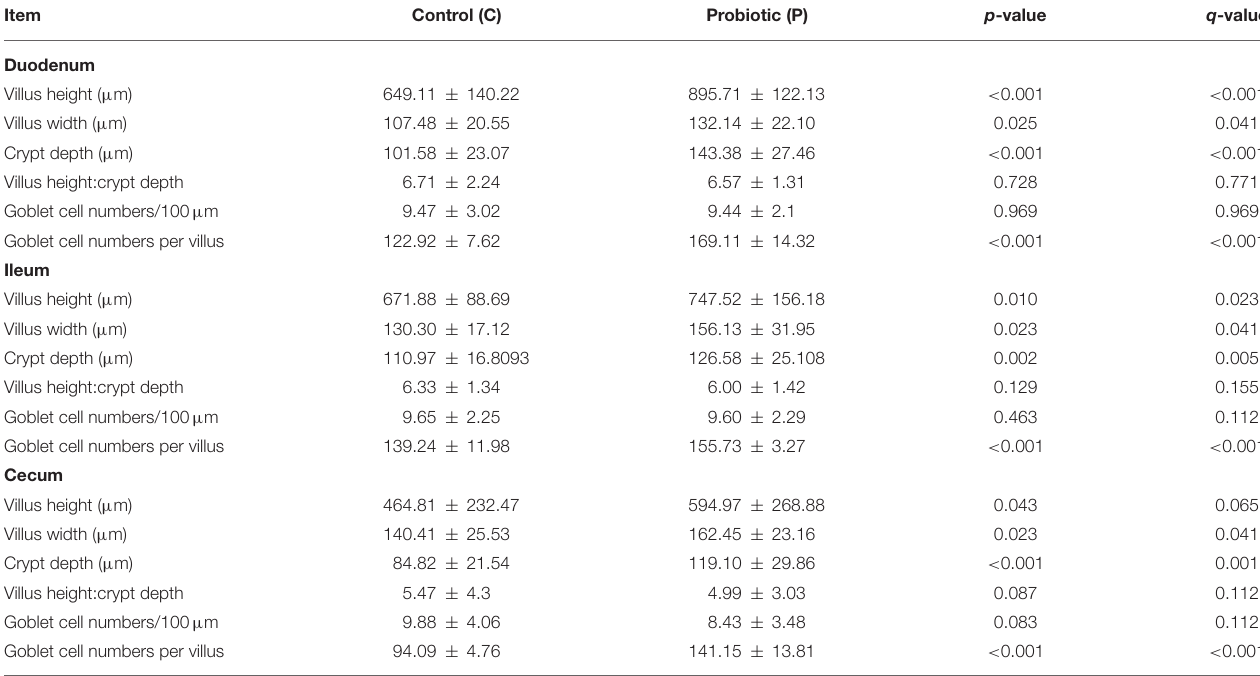
TABLE 2 | Effects of the multi-strain probiotic Slab51 ® supplementation on the intestinal morphology of two guinea fowls ( Numida meleagris ) groups (C and P) (mean ± standard deviation). Item Control